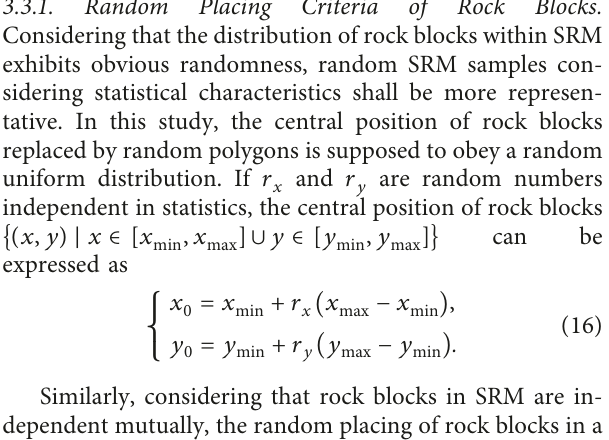
Figure 2. The vertex coordinates of random convex